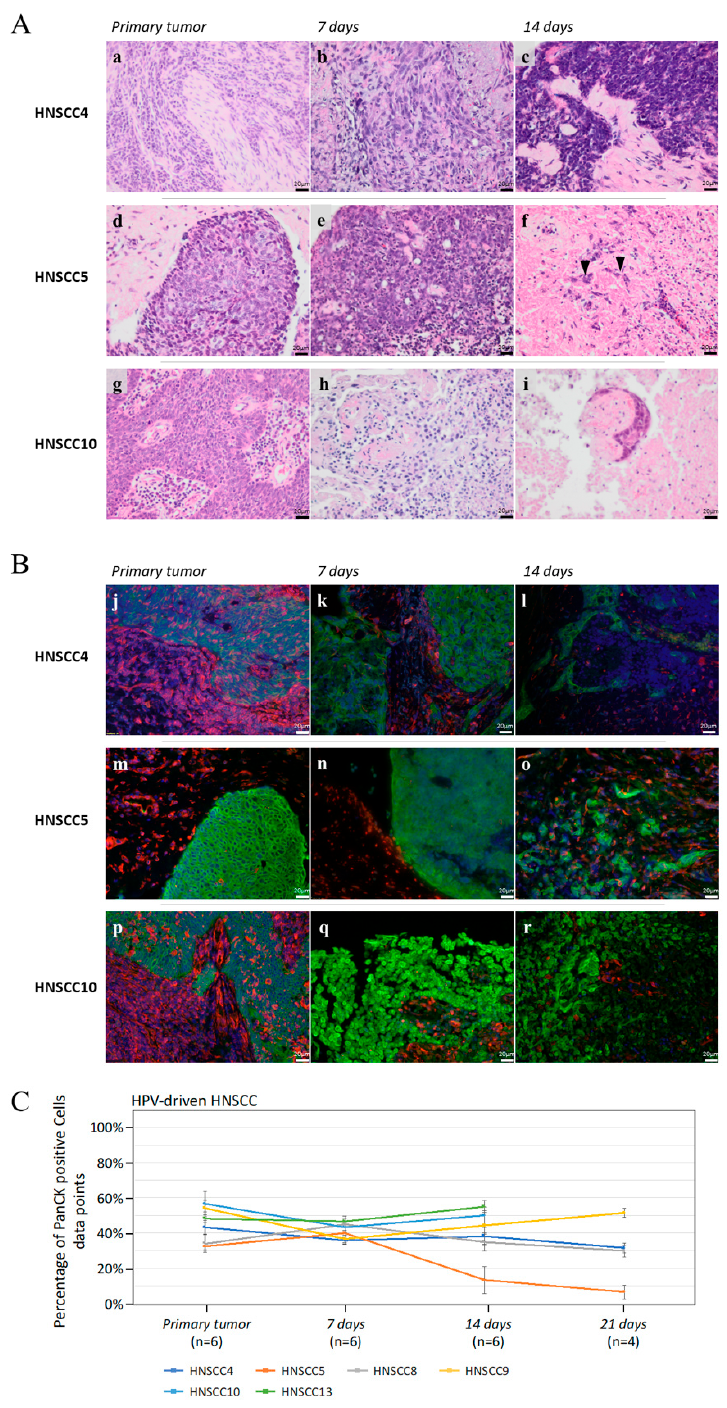
Figure 7. ( A ) H / E staining of three di ff erent HPV-driven 3D-HNSCC-OTC (b–f,h,i) and corresponding primaries (a,d,g). HNSCC4 maintains its tumorous morphology. HNSCC5 shows few remaining tumor cells on day 14 (f: black arrowheads) and HNSCC10 presents an altered morphology. Scale Bar: 20 µ m. ( B ) Co-immunofluorescence staining with an anti-PanCK-antibody (green), an anti-vimentin-antibody (red), and DAPI (blue) of the samples presented in ( A ), confirming the observations. Scale Bar: 20 µ m. ( C ) Mean values of tumor cell proportion of all primaries and 3D-OTCs on day 7, 14, and 21 of all HPV-driven HNSCC. Error bars indicate standard errors of the mean. Abbreviations: H / E, hematoxylin / eosin; HPV, human papillomavirus; 3D-OTC, 3D organotypic co ‐ culture; PanCK, pan ‐ cytokeratin.